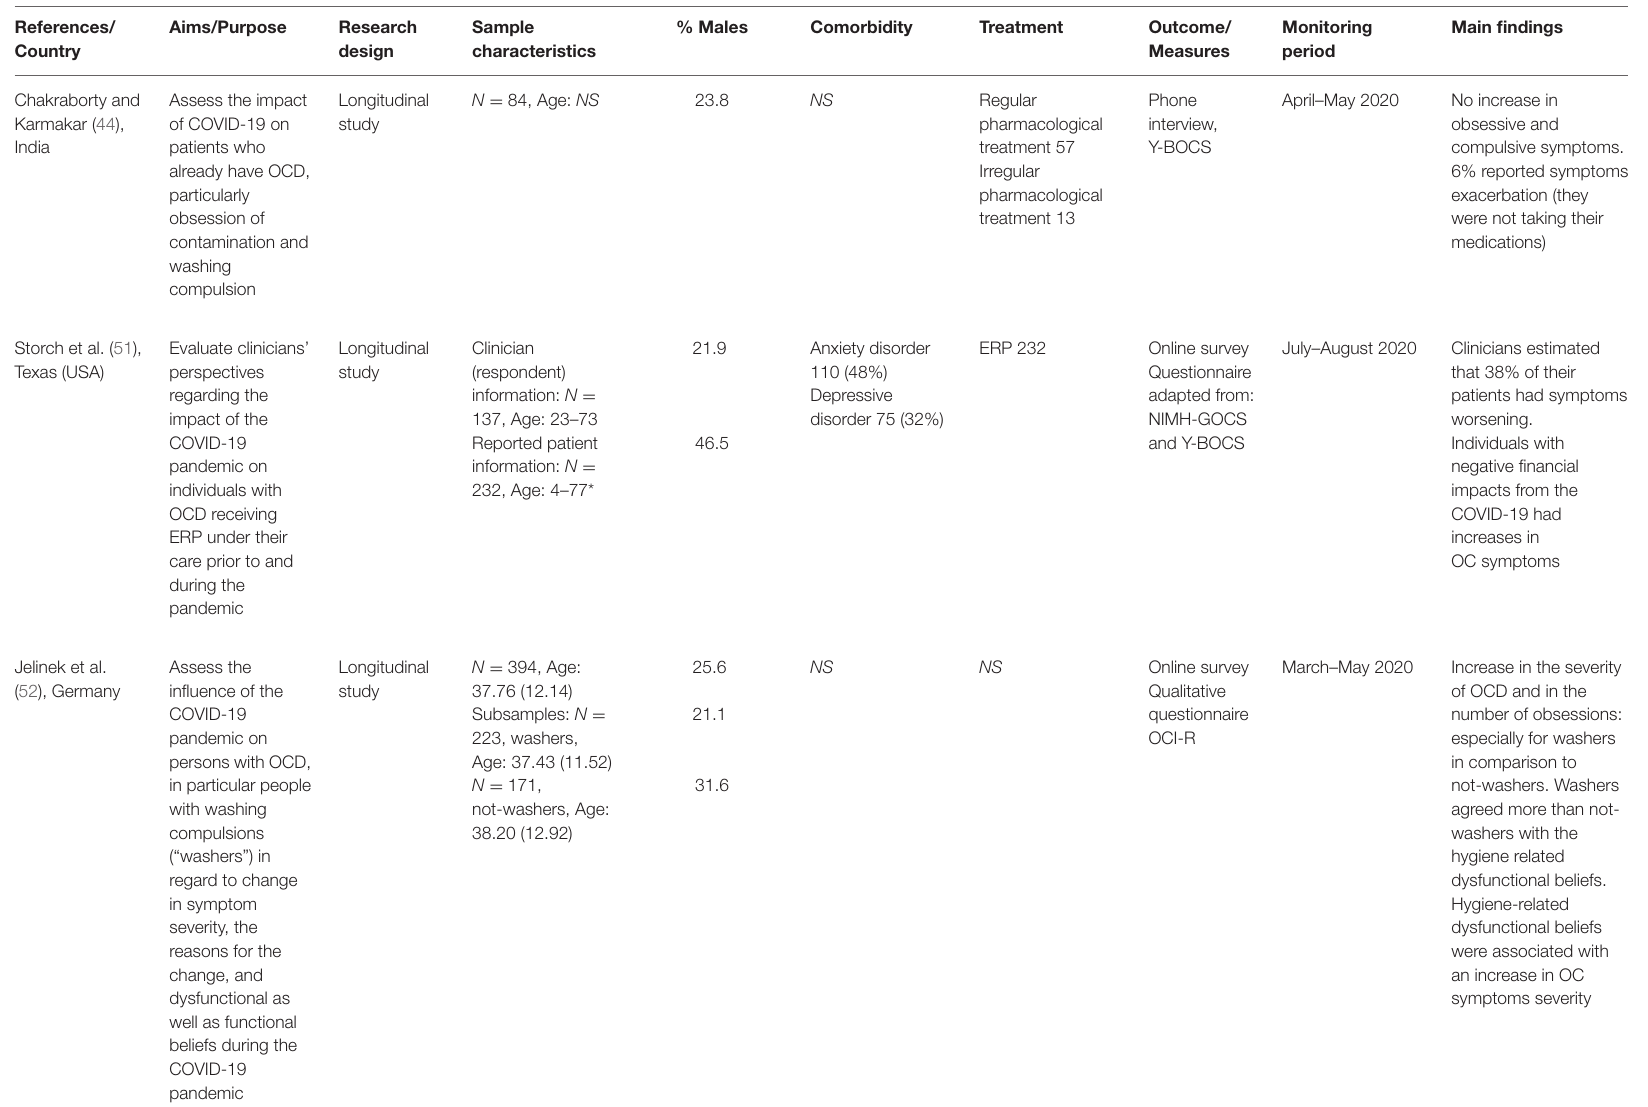
TABLE 1 | Studies among sample of